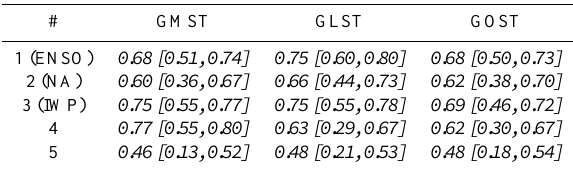
Table 4. Correlations between the mean time series of the commu- nities of the ESM-SST-LP8y network and the indices of mean, land and ocean surface temperatures (all time series 8y low-pass filtered). The 95% confidence intervals are given in brackets and correlations significant at 5% in italic